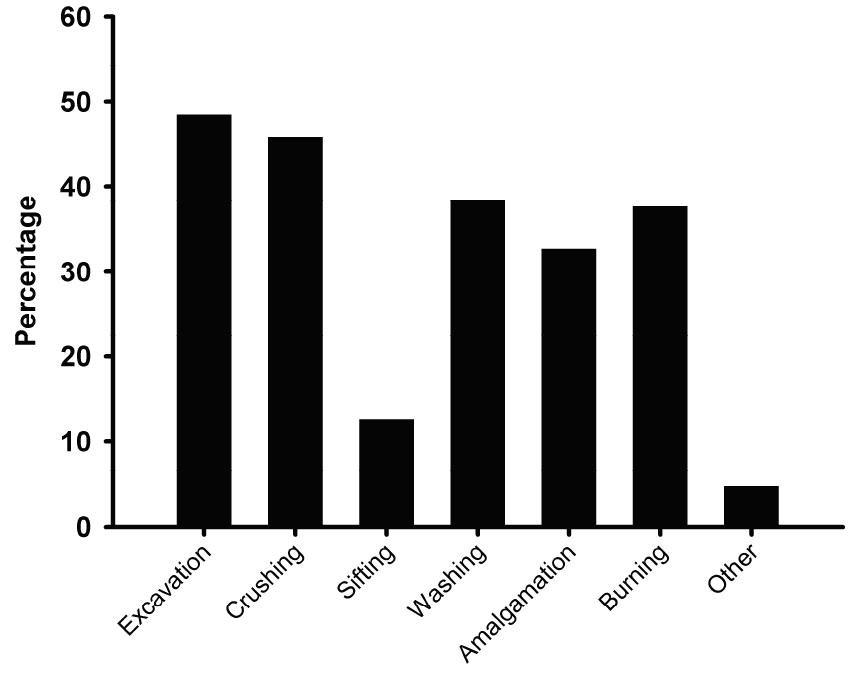
Figure 1. Self-reported routine activities of artisanal and small-scale gold miners from the Tarkwa (Ghana) study sites. Note, cumulative values exceed 100%, since many miners are regularly involved in more than one